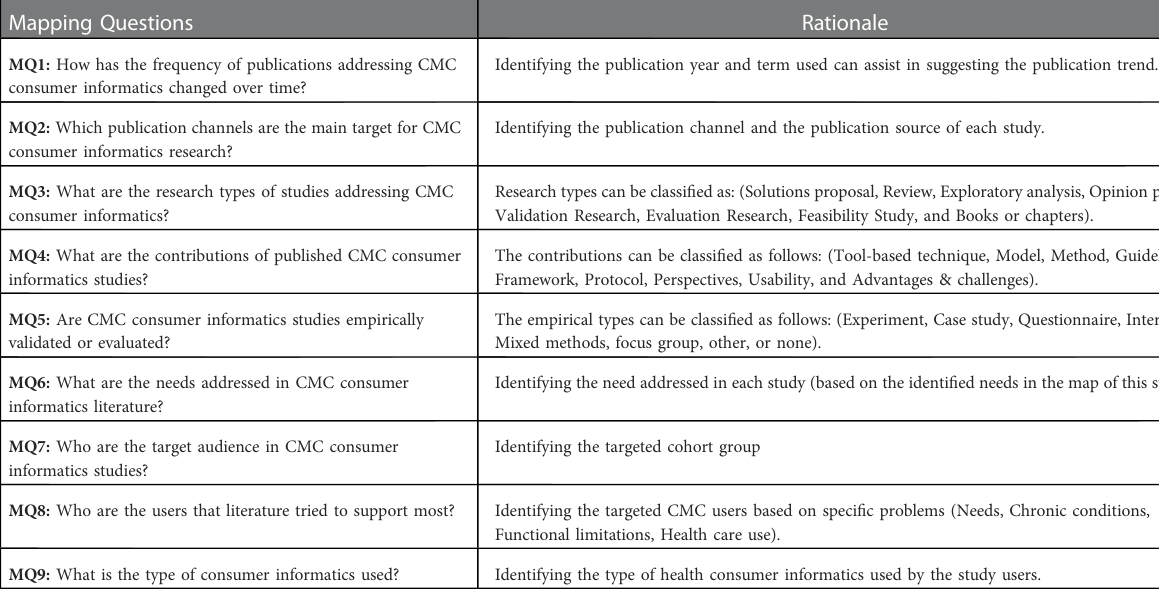
TABLE 1 Mapping questions and their